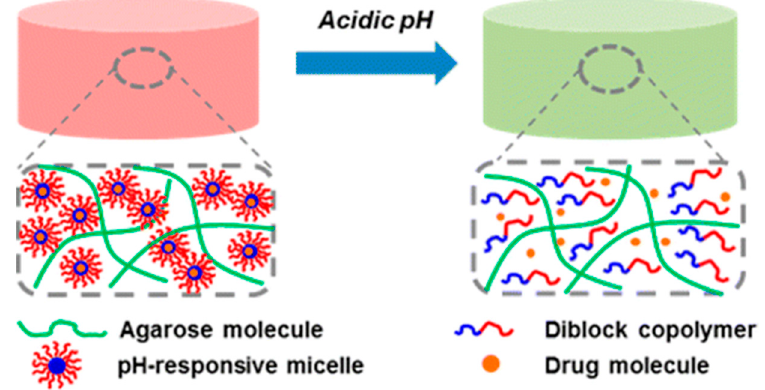
Figure 13. Schematic illustration of agarose hydrogels embedded with pH-responsive diblock copolymer micelles for triggered release of substances, reproduced with permission from [433]. Copyright American Chemical Society,